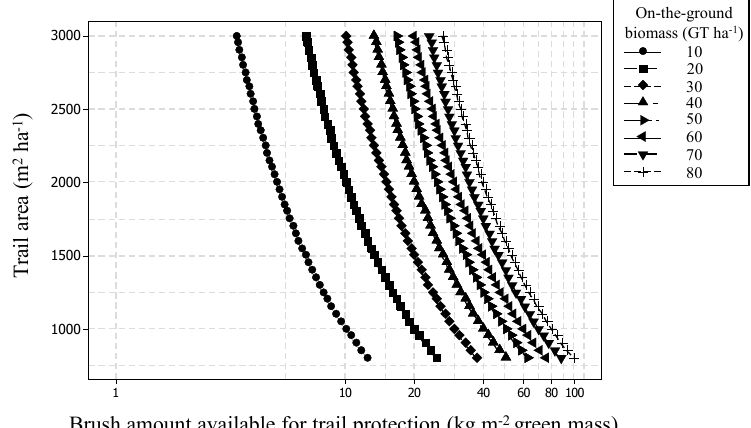
Figure 3. Relationship between machine operating trail area and brush amount available for soil protection on the trail based on varying on-the-ground biomass.